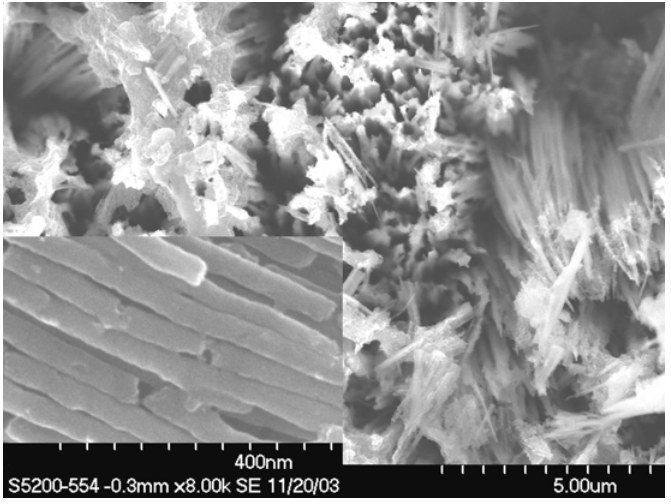
Figure 3. Polypyrrole nanowire array (SEM photograph).